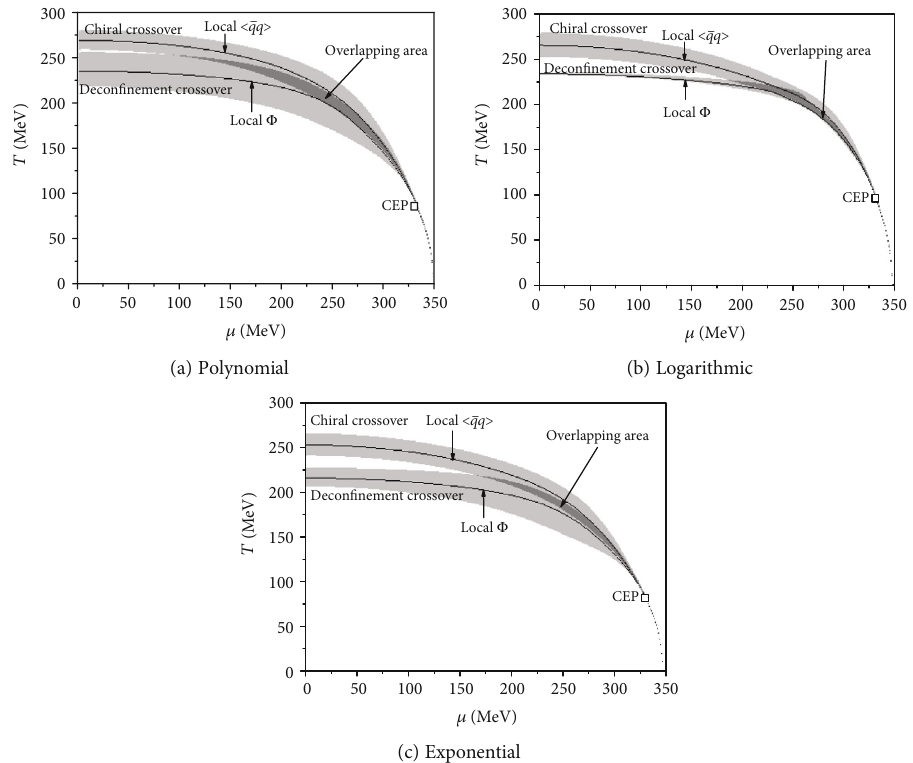
Figure 9: Phase diagram chiral and decon fi nement crossover superposition for locally based